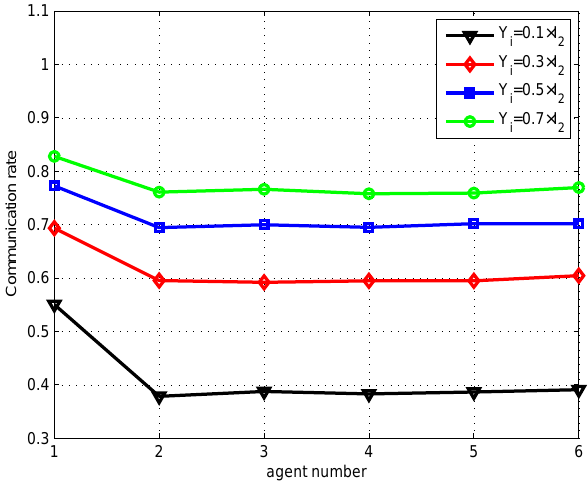
Figure 8. Communication rate for different Y i